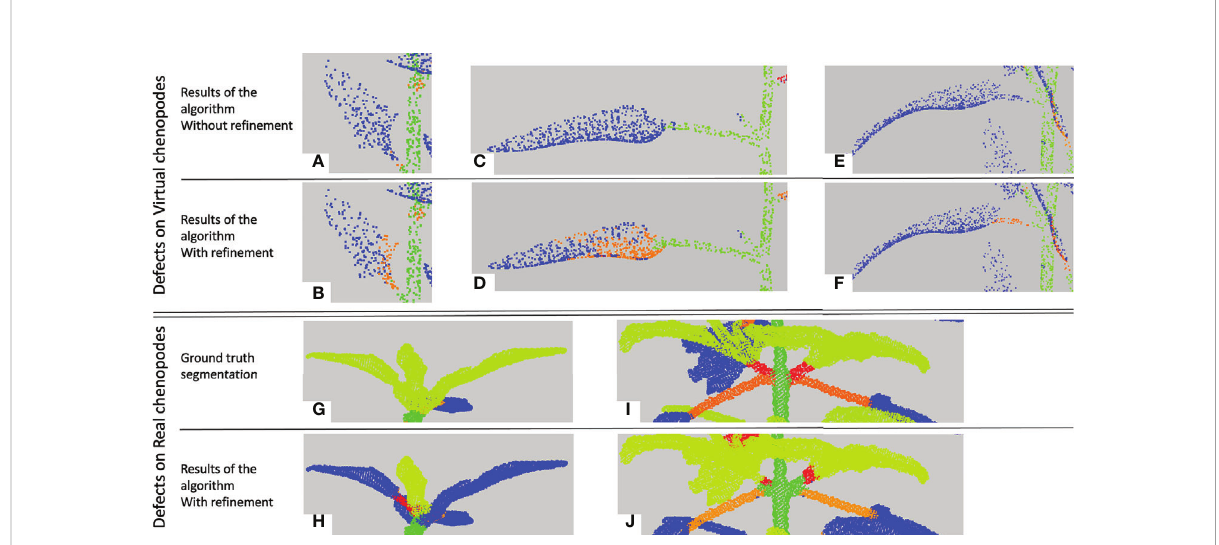
FIGURE 10 Main segmentation errors and re fi nement corrections. Five examples of semantic segmentations of different plant parts (A-J) . (A-F) are presented without (top row, a, c, e) and with (bottom row, b, d, f) re fi nement. (G, I) are the ground truth labelled point clouds of the part segmented by our algorithm in (H, J) . Points labelled as on a petiole are in orange, on a branch in red, on a leaf blade in blue, on an apex in yellow-green and on a stem in